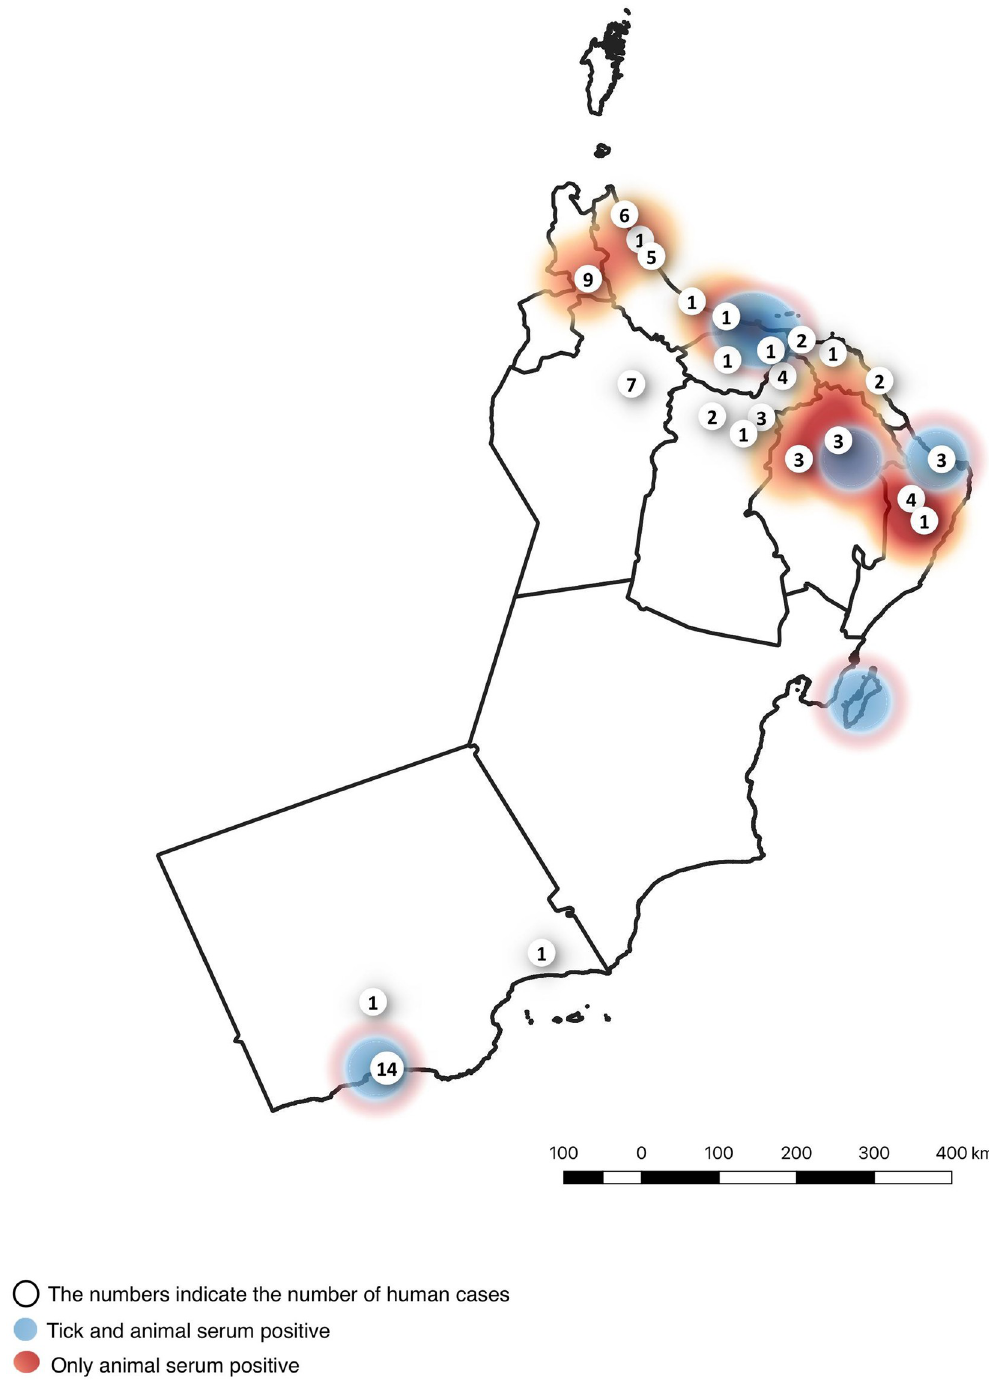
Fig 2. Map of Oman with number of CCHF cases, superimposed on results of previous animal serosurveys for CCHFV antibodies and tick surveys for CCHFV (24–25). The map was constructed using QGIS software (QGIS Development Team (2018). QGIS Geographic Information System. Open Source Geospatial Foundation Project. http://qgis.osgeo.org) using data from the directorate general for planning, ministry of health, Oman.